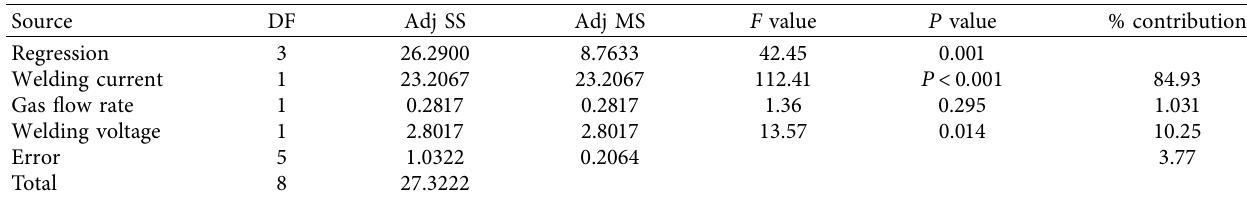
Figure 5: Main effects plot for means on microhardness. Table 4: Analysis of variance for hardness.